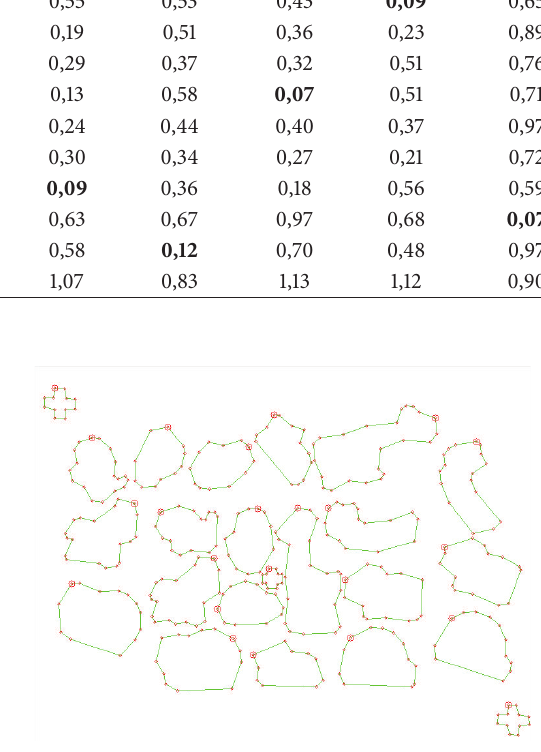
Figure 9: Example of an image with different puzzle pieces. Figure 10: Extracted and approximated contours of the puzzle